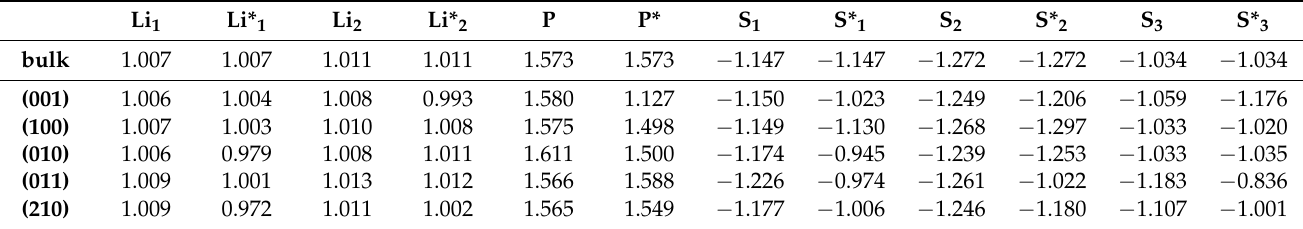
Table 4. Hirshfield charges of β -Li 3 PS 4 Pn2 1 a bulk and eight-unit surfaces for the surface (indicated by *) and internal atoms.